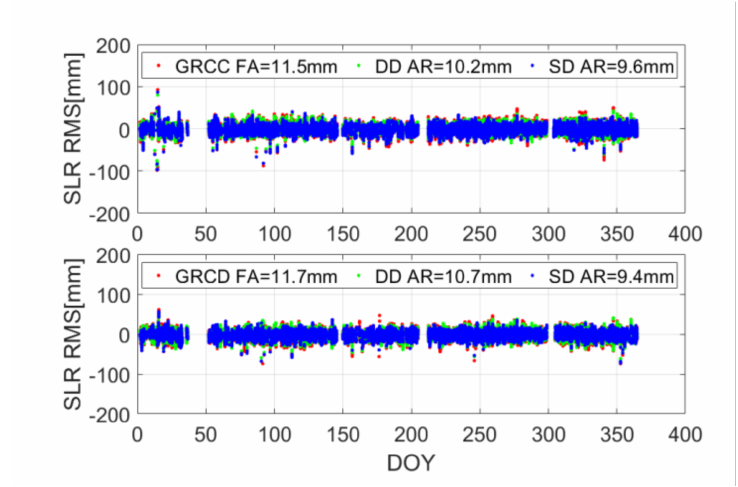
Figure 9. RMSs of SLR residuals derived from FA (red dots), DD AR (green dots), and SD AR (blue dots) solutions. The upper panel is for the GRCC satellite and the lower panel is for the GRCD satellite.